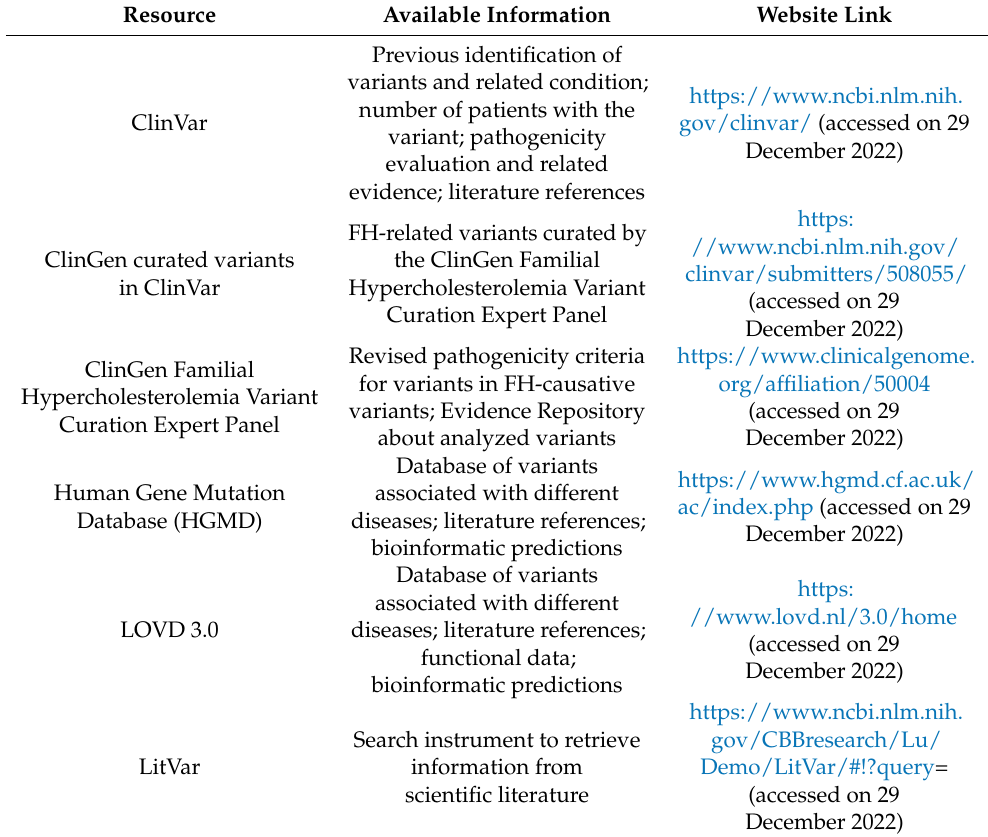
Table 2. Online resources useful to retrieve data about genetic